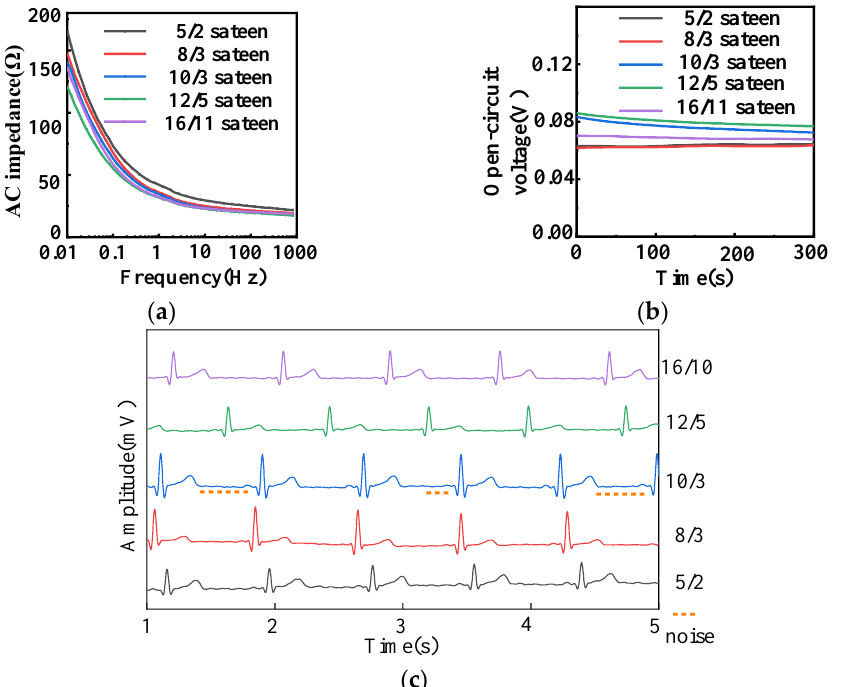
Figure 5. ( a ) AC impedance, ( b ) open-circuit voltage, and ( c ) static ECG signals of different fabric weaves with 4 cm diameter and 35 picks/cm for fabric electrodes.